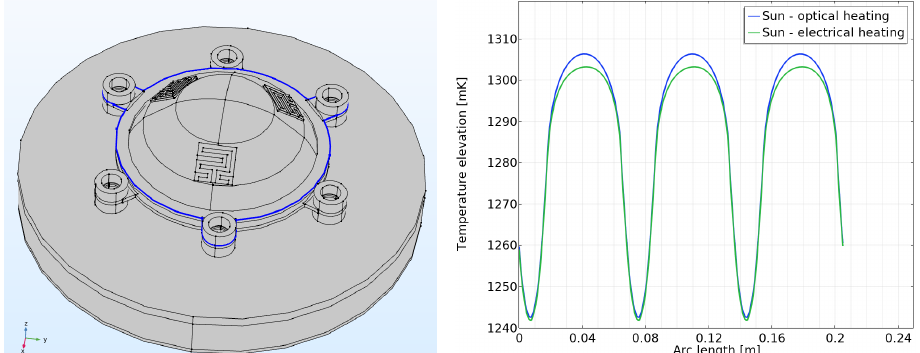
Figure 8. We analyse the temperature elevation along the blue curve that follows the edge of the spherical part of the cavity, passing by the three heat sinks of the cavity ( left ). The graph ( right ) shows the temperature distribution along this curve, for both optical and electrical